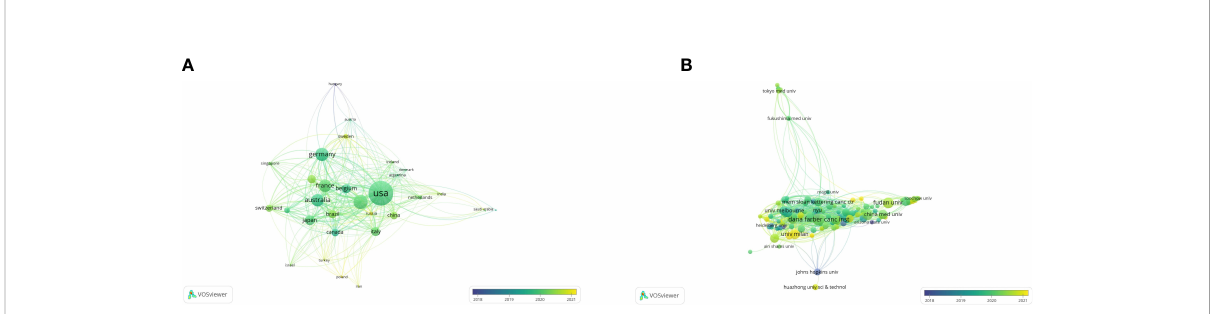
FIGURE 3 The co-authorship analysis of countries and organizations. (A) The overlay map of co-authorship between countries (blue: earlier, yellow: later). (B) The overlay map of co-authorship between organizations (blue: earlier, yellow: